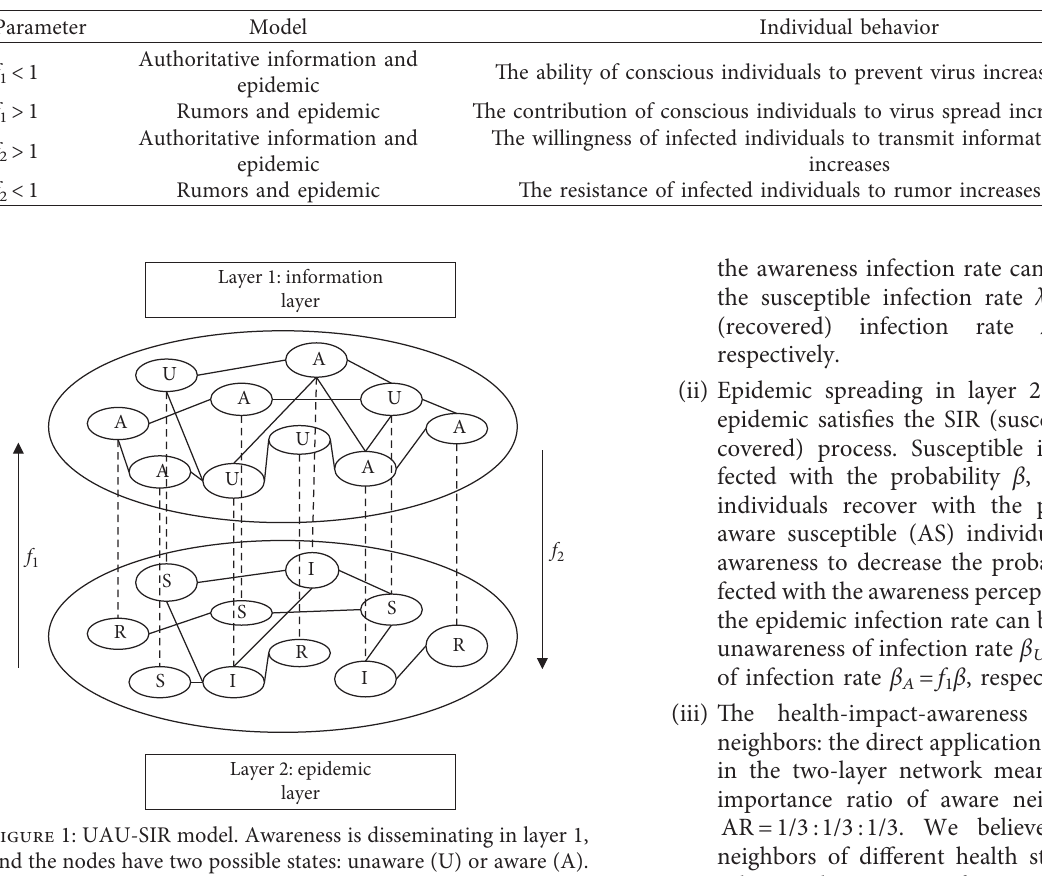
Table 1: Parameter meaning and influence on individual behavior.